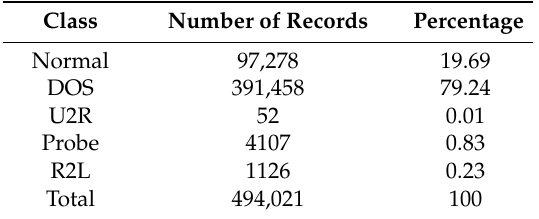
Table 1. The distribution of the 10% knowledge discovery and data mining (KDD) training data.